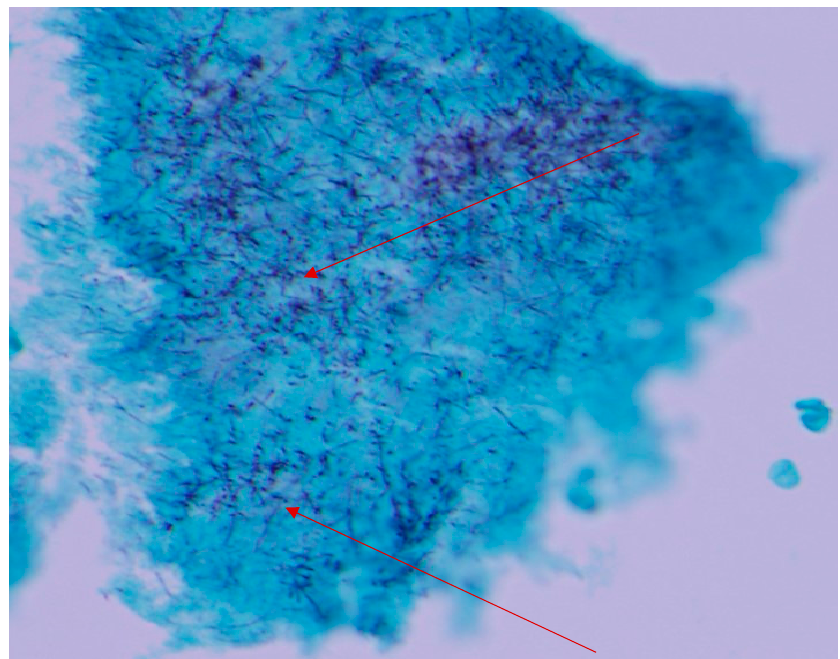
Figure 4. Sulfur granule (arrow) showing embedded organisms on H&E stain. Original magnification ×200. Diseases 2018 , 6 , x